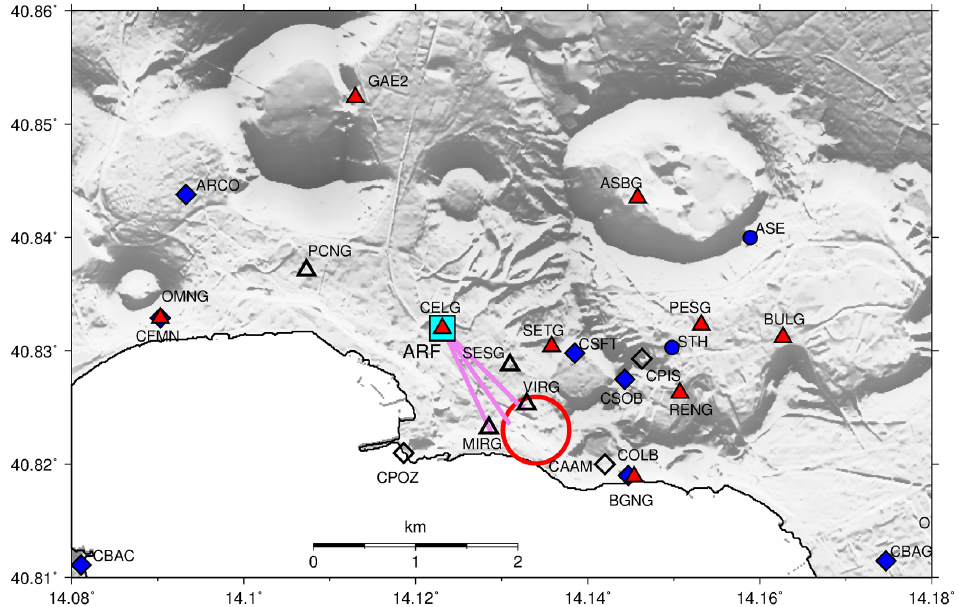
Figure 9. Raw epicentral area (circle) of the hydrothermal volcanic tremor recorded in Campi Flegrei on January 30, 2015. The backazimuth range obtained by array analysis of ARF data is shown by magenta lines, while empty symbols represent seismic stations not available on that day (VIRG, MIRG, SESG and PCNG were installed later).